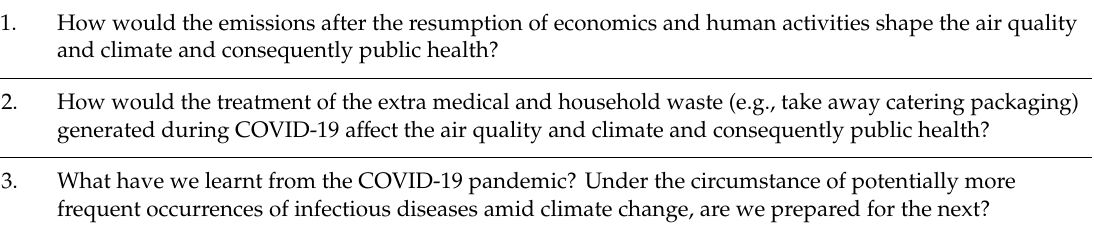
Table 2. Some of the important questions for